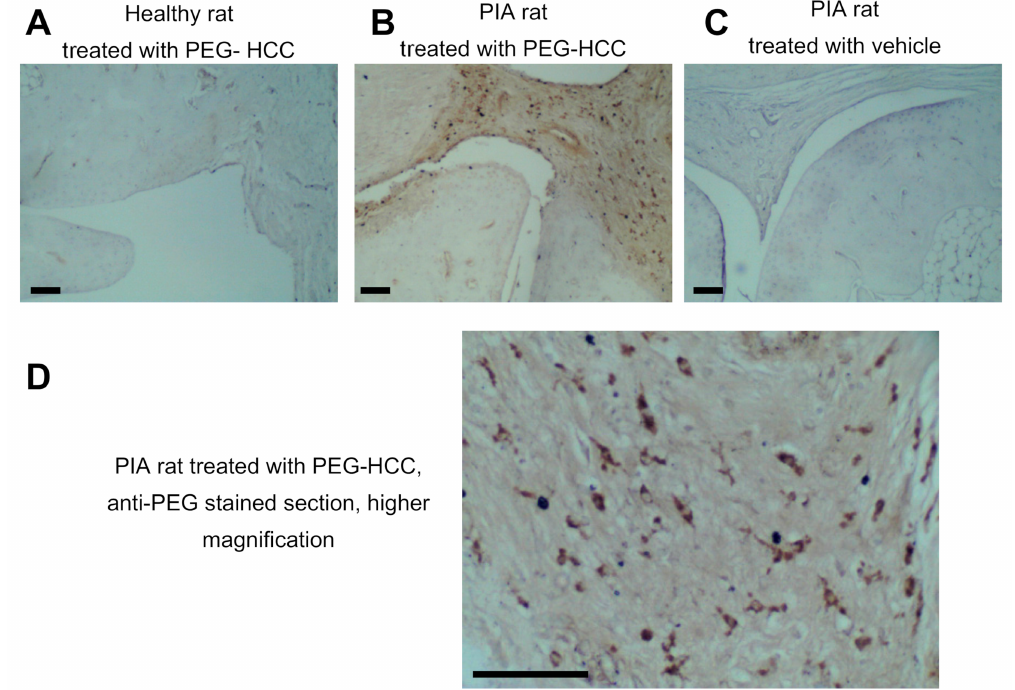
Figure 3. PEG-HCCs enter spindle-shaped cells in the synovium of rats with a model of RA. ( A – C ) Staining of PEG (brown) in the synovium of a healthy rat treated with PEG-HCCs ( A ), a PIA rat treated with PEG-HCCs ( B ), and a PIA rat treated with vehicle ( C ). ( D ) Higher magnification of a section from a PIA rat treated with PEG-HCCs and stained with anti-PEG antibodies. Scale bar = 100 µ